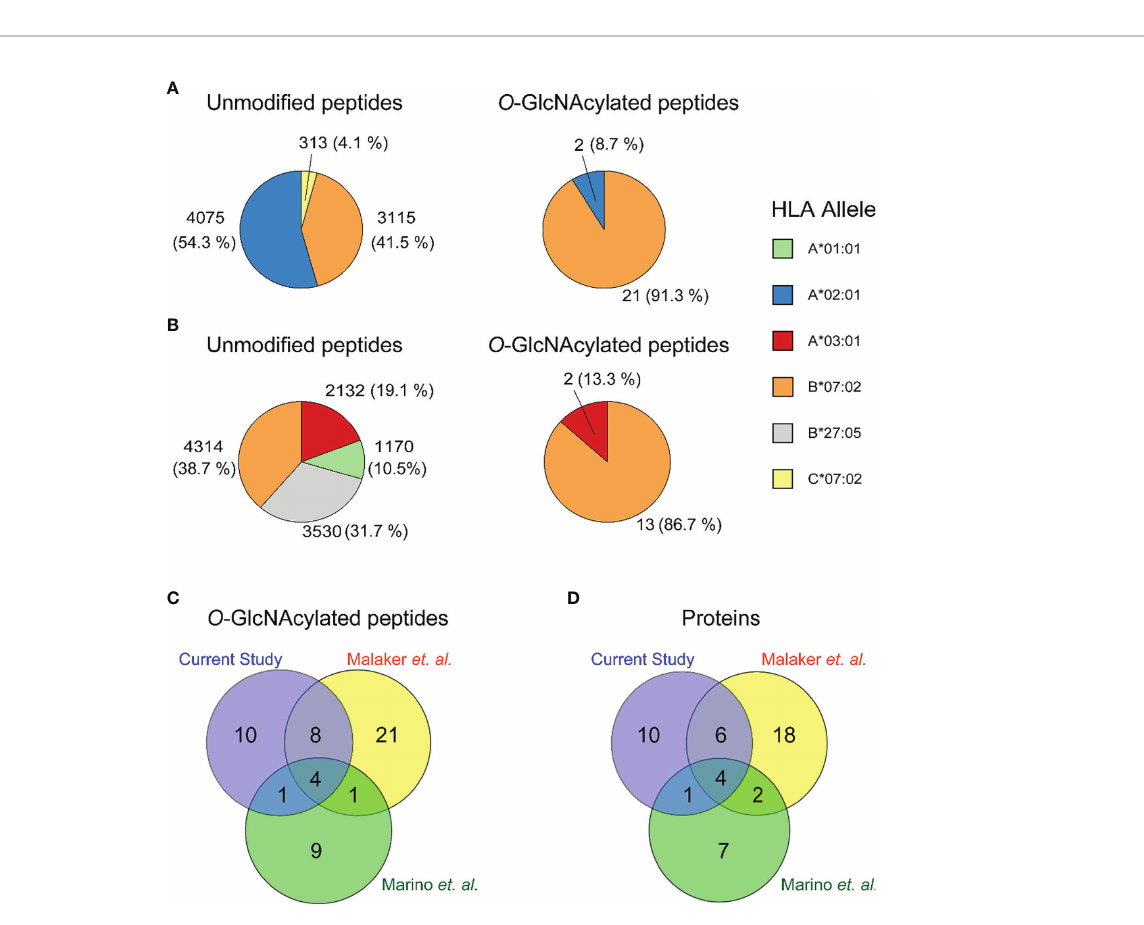
FIGURE 2 | Distribution of the identi fi ed unmodi fi ed (left) and O -GlcNAcylated (right) HLA class I peptides over (A) the JY HLA alleles in the current study, and (B) all HLA alleles in the GR-LCL cell line (C) Overlap in identi fi ed peptides in the current study (purple), Malaker et al. (yellow) and Marino et al. (green). (D) Overlap in identi fi ed proteins in the current study (purple), Malaker et al. (yellow) and Marino et al. (green).